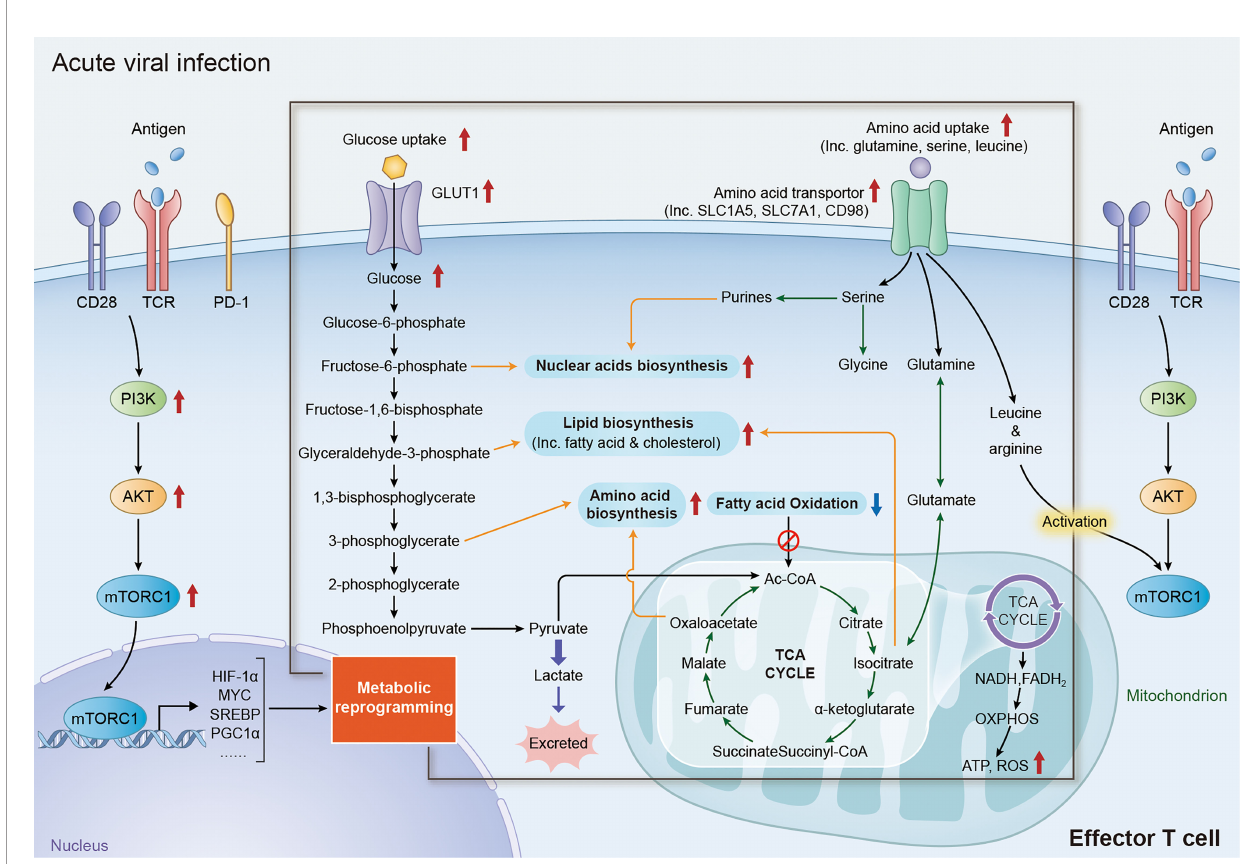
FIGURE 1 | Metabolic reprogramming of effector T cells in acute viral affection. Upon recognition of speci fi c antigen via TCR/CD28 receptor, T cells rapidly initiate the signaling of PI3K/AKT/mTORC1 axis and upregulate the expression of its downstream factors including MYC, HIF1 a , SREBPs and PGC1 a , reprogramming the expression of metabolic transporters and enzymes. Increase expression of glucose transporter family members and glycolytic enzymes dramatically promote the activity of aerobic glycolysis in effector T cells, which not only provide ef fi cient energy generation, but also fueling multi biochemical intermediates that are necessary for nucleotide, amino acid, fatty acid synthesis and mitochondrial function. The reprogramming of amino acid metabolism, especially the changes of glutamine, serine, arginine and leucine metabolism, plays an important role in the activation and functional maintenance of T cells. Augmentation of glutamine metabolism can promote the acetylation reactions or lipid synthesis by acting as an anaplerosis source in the TCA cycle. Increasing level of serine promotes the activity of nuclear acid biosynthesis in effector T cells by fueling the precursor for one-carbon metabolism. In addition, high level of leucine and arginine is required for the full activation of mTORC1 activity in both CD4 + and CD8 + T cells. TCR, T-cell receptor; PI3K, phosphoinositide 3-kinase; AKT, protein kinase B; mTORC1, mechanistic target of rapamycin complex 1; HIF1 a , hypoxia-inducible factor 1- alpha; SREBPs, sterol regulatory element binding proteins; PGC1 a , peroxisome proliferator-activated receptor gamma coactivator 1-alpha; TCA, tricarboxylic